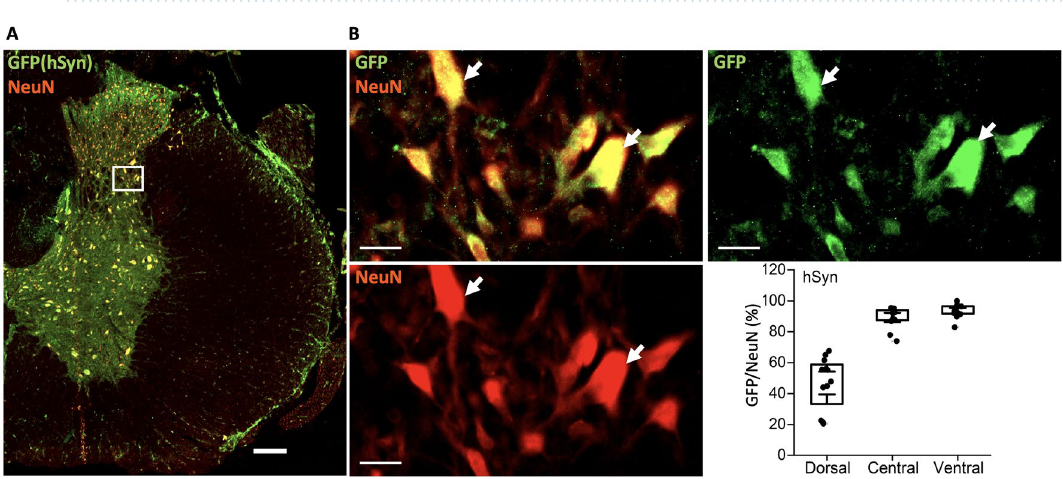
Figure 6. AAV9-CamKIIa-infected cells has poor overlap with GAD65 and GAD67 biomarkers. ( A ) Top row: mScarlet expression (red, RFP) and the immunostaining of GAD65 (cyan) has only little co-expression, and second row: threshold representations of the original images and a heat map co-expression plot of RFP/ GAD65. ( B ) Top right grey box: plots show poor correlation in pixel-overlap between RFP and GAD65. ( C ) First row: original images of RFP, GAD67 (green) and their overlap, and bottom row: threshold representations of the original images and the heat map of RFP/GAD67. ( D ) Bottom right grey box: the mosaic of correlation coefficients for various thresholds, indicate poor overlap between RFP and GAD67. (N = 3 rats, n = 3-4 sections/ rat). Scale bar 20 µ m.